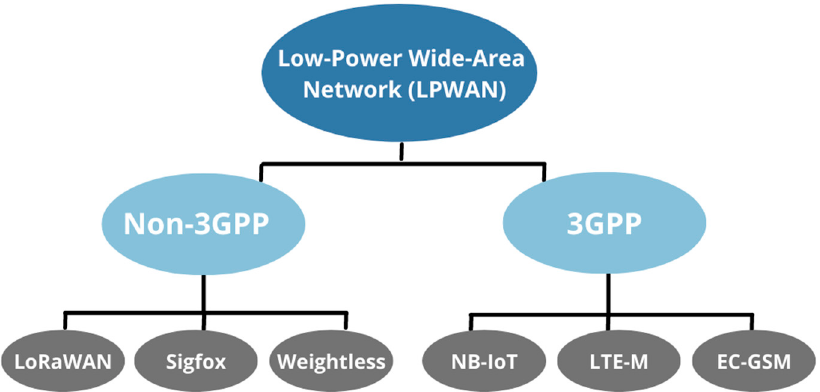
Figure 2. Classification of licensed (3GPP) and non-licensed (non-3GPP) LPWAN technologies.